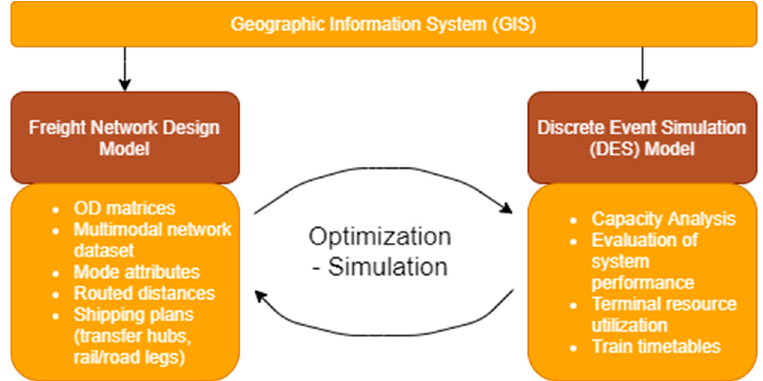
Figure 1. Sequential optimization simulation framework.